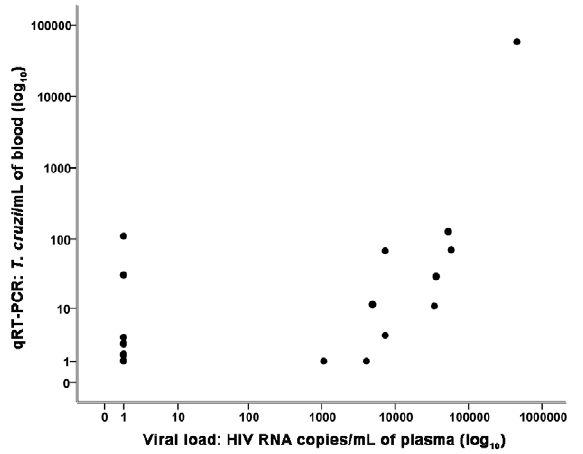
Figure 6. Correlation between number of T. cruzi/mL of blood (qRT-PCR) and HIV RNA copies/mL of plasma). Spearman’s correlation coefficient ( r s )=0.584, P =0.007 (Analysis of 20 samples from patients infected with HIV/ T. cruzi with and without Chagas disease reactivation). In this Figure, 8 samples were superimposed in the lower limit of viral load and number of parasites/mL.